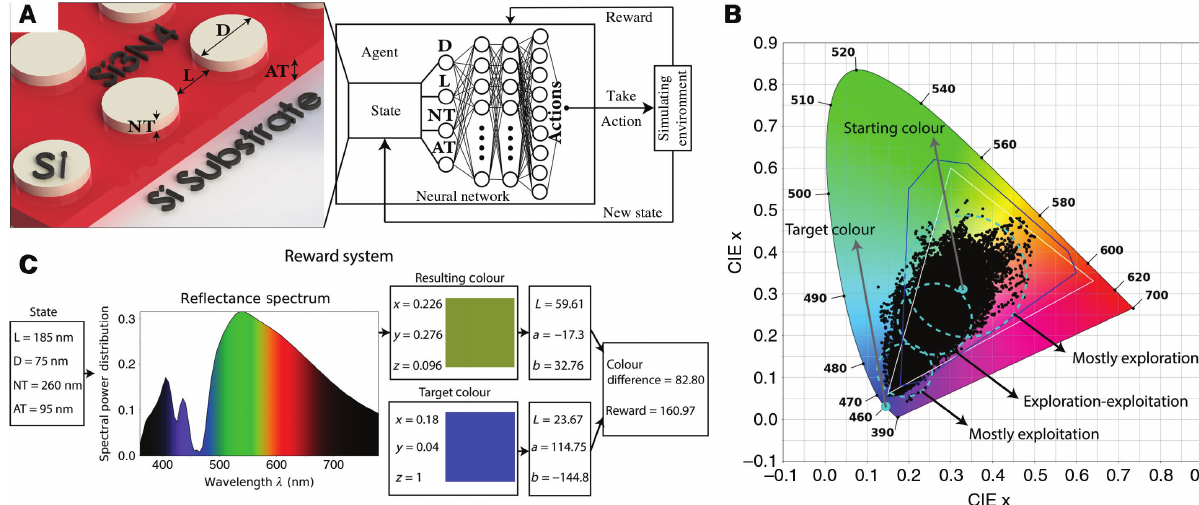
Figure 8: Reinforcement learning used to optimise the parameters of a dielectric color filter. (A) A schematic of the nanostructure and DNN design. (B) The data points as the agent traverses the parameter space and reaches the goal of finding the bluest possible color. (C) The reward system based on the Lab color space color difference. Figures are adapted with permission from Ref. [95], The Optical Society